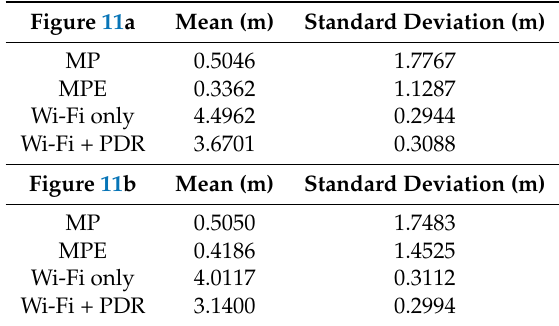
Table 2. Comparison of experimental results shown in Figure 11. Figure